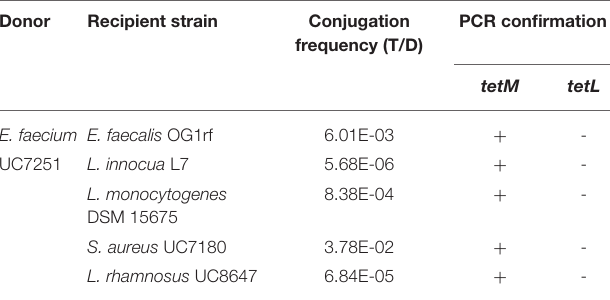
TABLE 2 | Conjugation of tetracycline resistance between E. faecium UC7251 and strains from other genera.